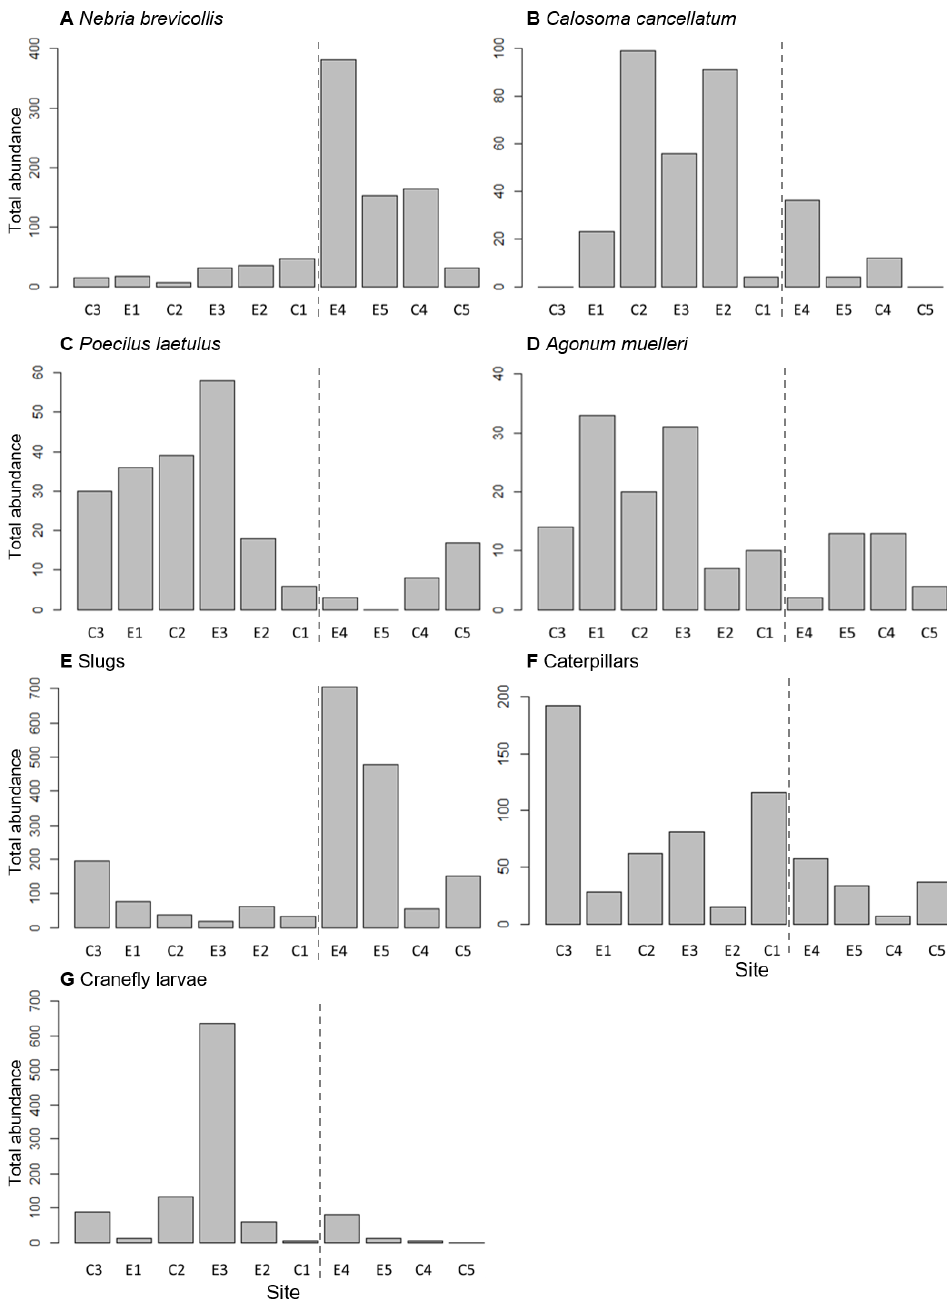
Figure 2. Total number of Nebria brevicollis ( A ), Calosoma cancellatum ( B ), Poecilus laetulus ( C ), Agonum muelleri ( D ), slugs ( E ), caterpillars ( F ) and cranefly larvae ( G ) caught per site over the duration of this study; sites are ordered by average soil moisture, from wettest (C3) to driest (C5) (see Table S4). Sites to the left of the broken line are those with a gravel margin, sites to the right have a vegetation margin.